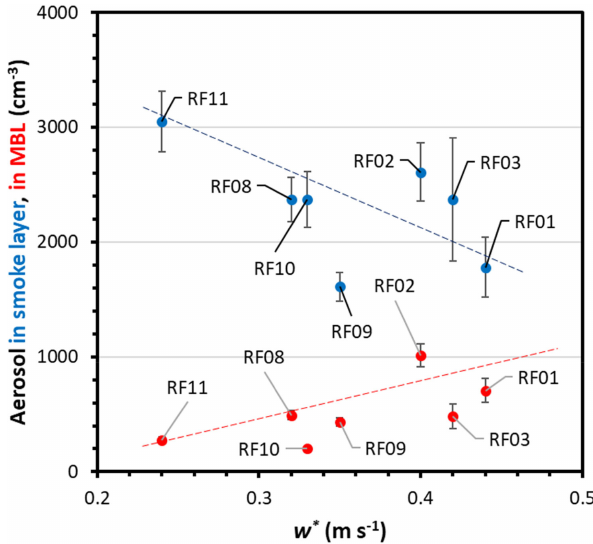
Figure 5. Characteristic velocity, w ∗ , in the MBL as a function of N a (cm − 3 ) in the BBOA plume (blue) and in the MBL (red), for each